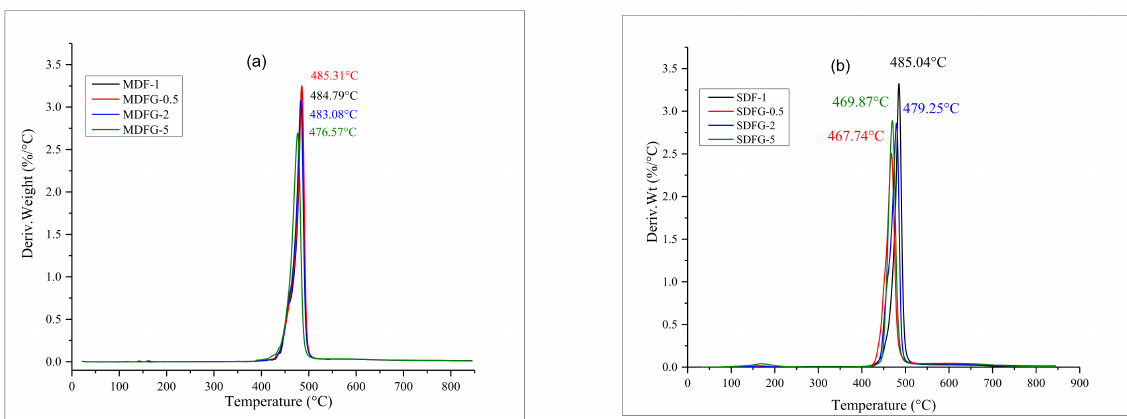
Figure 8. Overlay graphs of DTG of nanocomposites prepared by: ( a ) melt-mix method, and ( b ) by a solution-cast